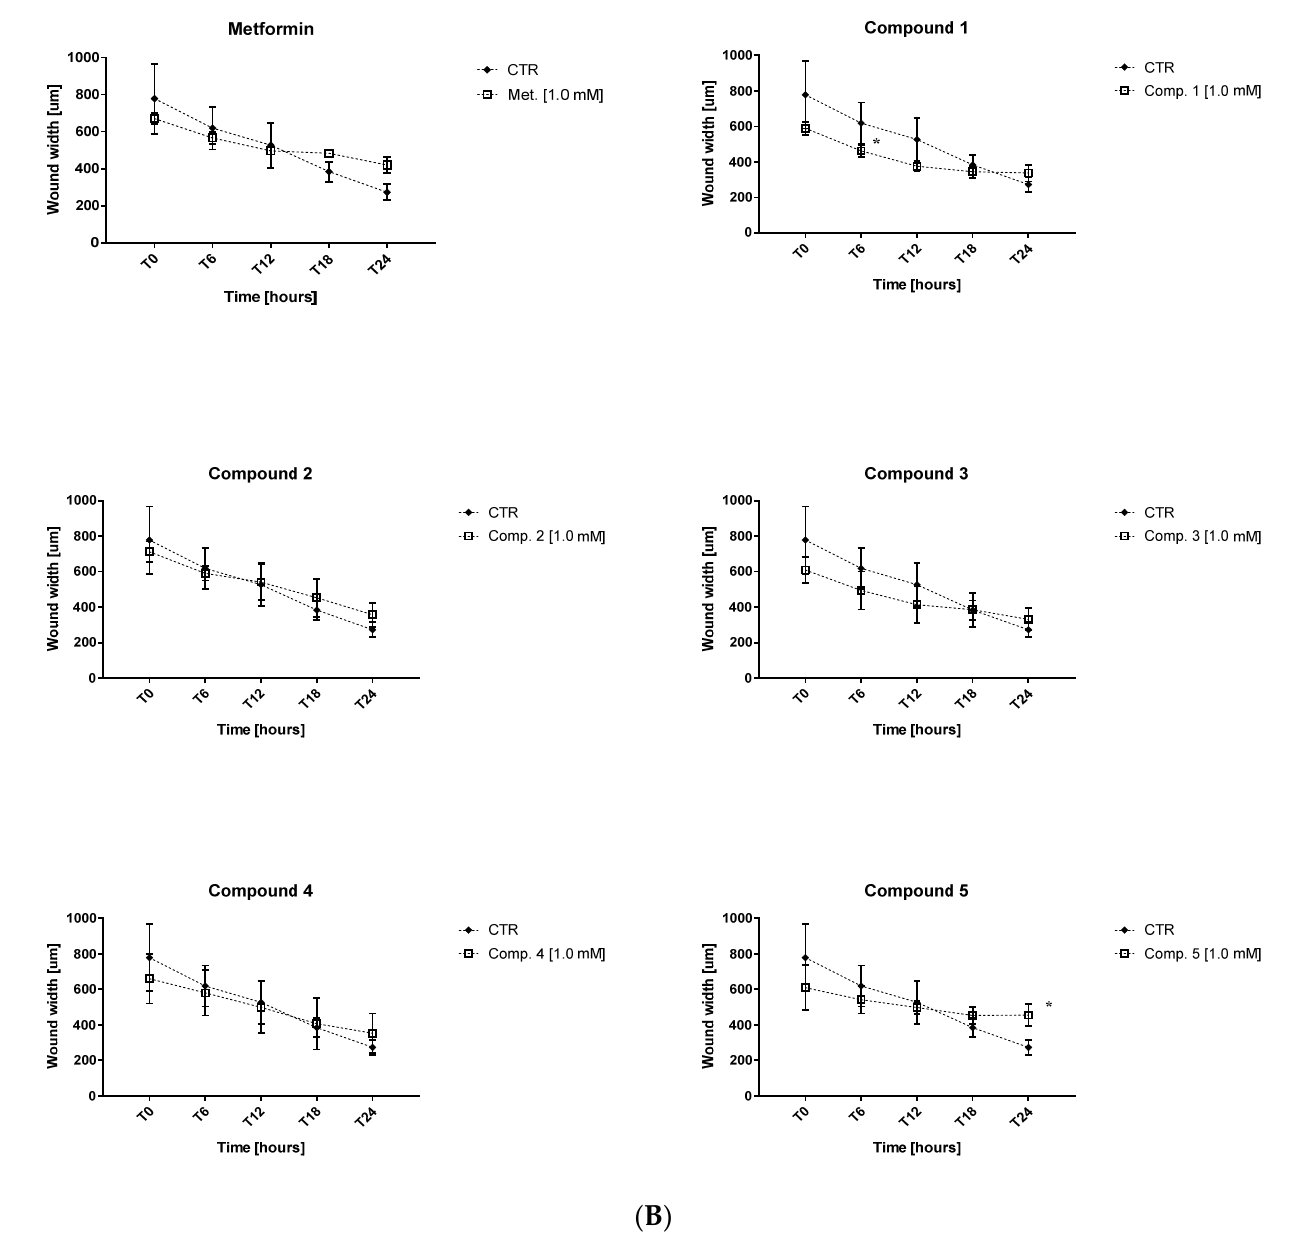
Figure 5. Impact of selected sulfonamides 1 – 5 and metformin on the migration of HUVECs was analyzed using wound ‐ healing assay in the JulieStage system. The represented graphs reflect changes of the wound width ( μ m) during 24 h in the absence (control) and in the presence of selected compounds at the concentration of 0.3 ( A ) and 1.0 mM ( B ). The results are presented as mean ± SD, n = 4–8; (* p < 0.05).